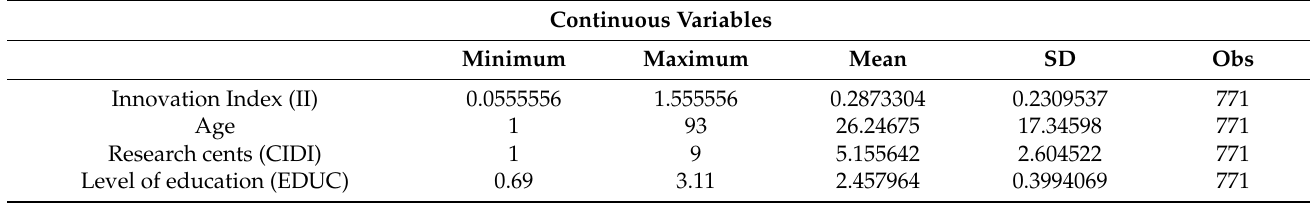
Table 2. Descriptive statistics for the variables in the